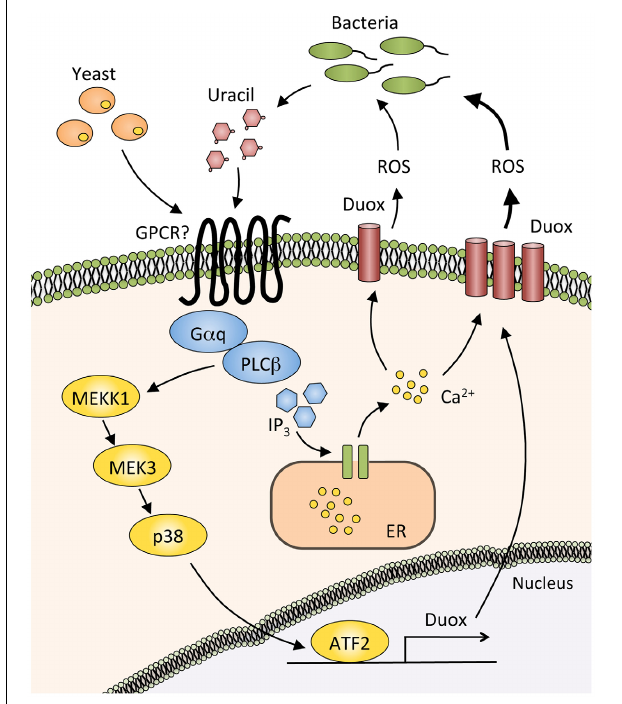
FIGURE 2 | Production of reactive oxygen species by the Duox pathway. In basal conditions, dietary yeasts or small amount of uracil from commensal bacteria activate the G protein alpha subunit q (G α q) and phospholipase C β (PLC β ), thereby inducing the synthesis of inositol (1,4,5)-triphosphate (IP 3 ), which binds to IP 3 receptor in the endoplasmic reticulum (ER). Calcium ions are then released from ER into the cytosol, resulting in the activation of a reactive oxygen species (ROS)-producing enzyme Dual oxidase (Duox). Duox expression is strongly induced by the large amount of uracil produced by pathogenic bacteria. PLC β mediates this Duox upregulation through triggering the MEKK1/MEK3/p38 MAPK pathway and activating Activating Transcription Factor2